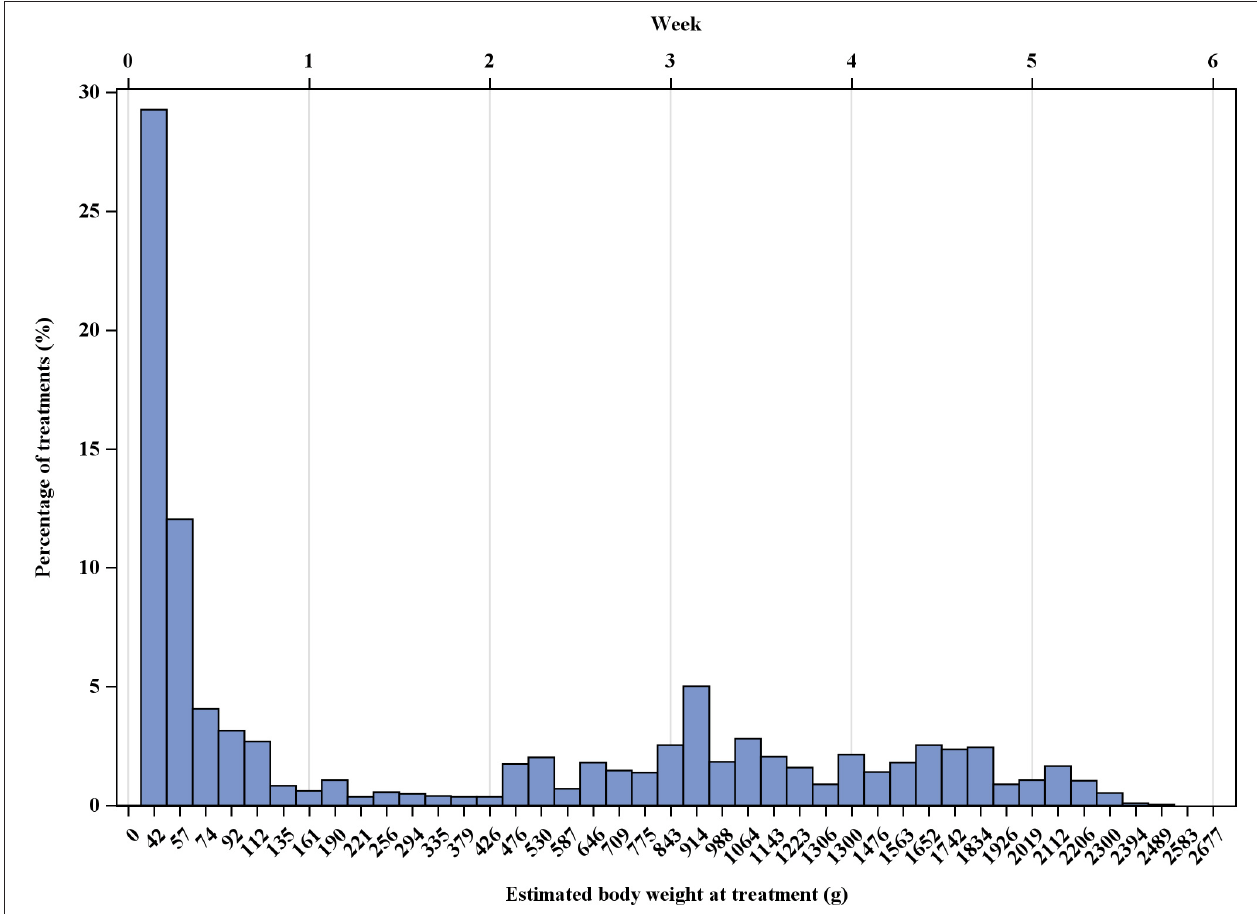
FIGURE 2 | Statistical distribution of the treatments by the estimated body weight of the broiler chickens in g over the entire study period